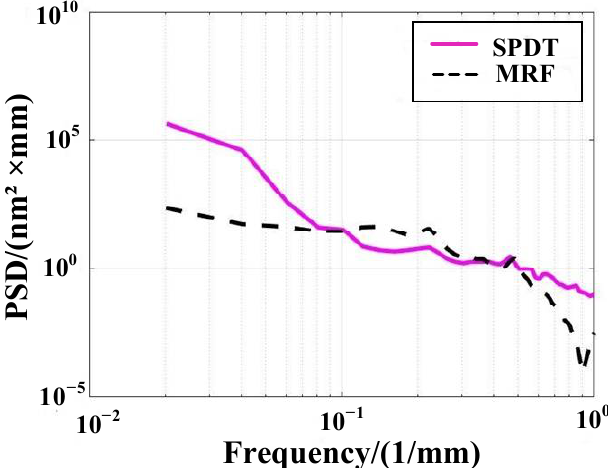
( b ) Figure 12. Influence of smoothing process optimization on surface roughness. ( a ) Surface roughness optimized by smoothing process; ( b ) surface roughness with too strong chemical action of smooth- ing fluid. The reflectivity of the modified layer in each processing process was measured. The experimental results are shown in Figure 13. The roughness will deteriorate after the MRF and improve after the CCOS. Therefore, the reflectance decreases after MRF and returns to the previous level after CCOS.